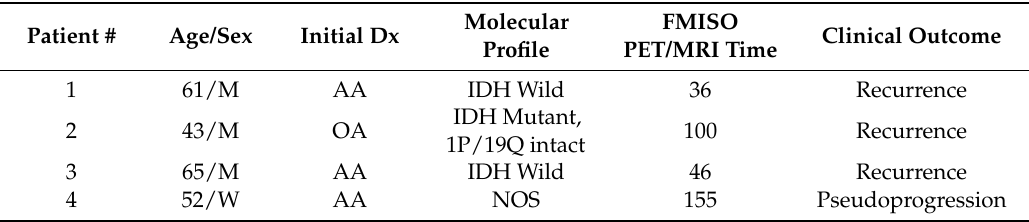
Table 1. Patient demographics and clinical